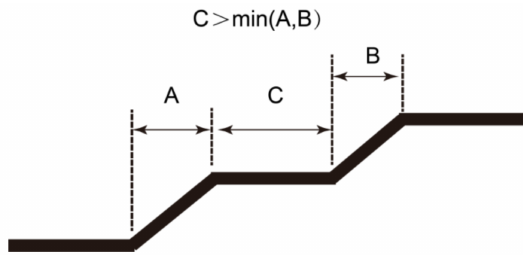
Figure 15. Requirement for continuous transition regions.